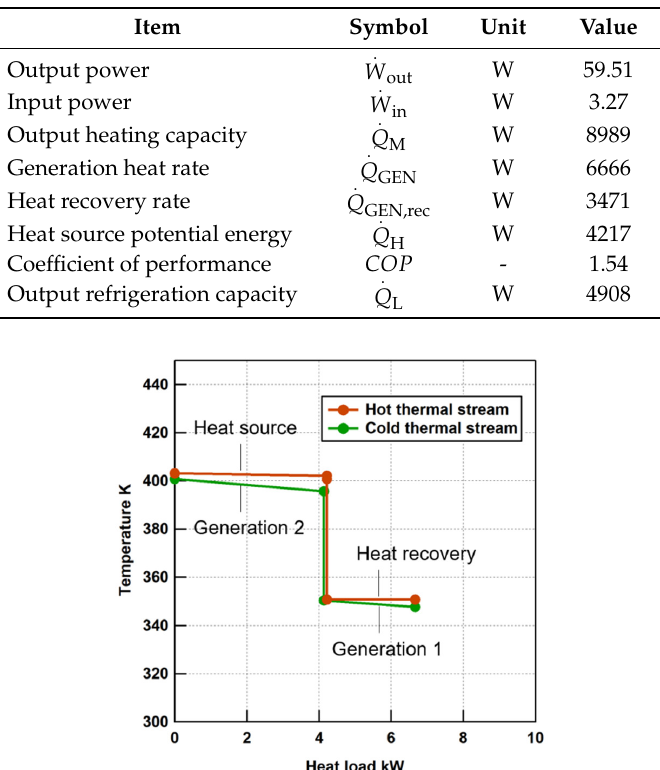
Table 3. Calculated values about the energy exchange rate in case Y.